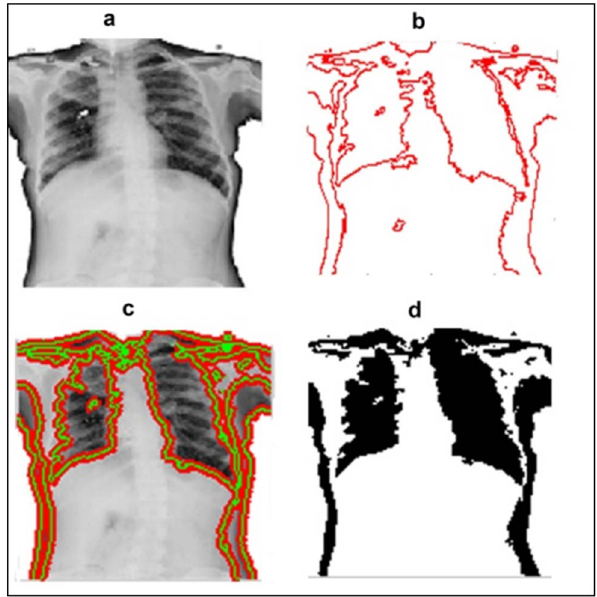
Figure 3. Chan-Vese active contour segmentation of a CXR. a. Original CXR image b. Initial contour c. Iterations for foreground segmentation, and d. Segmented image.